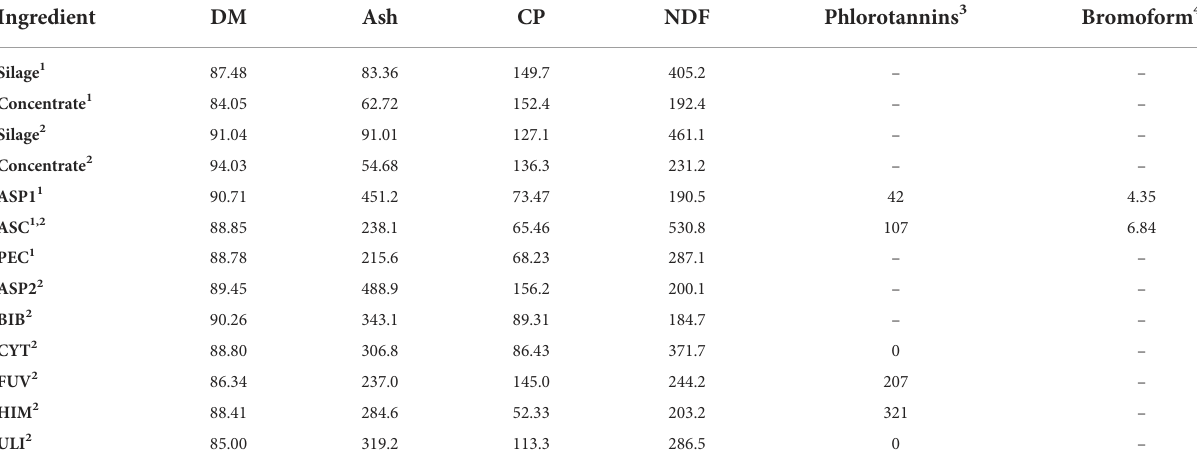
TABLE 2 Chemical composition of seaweed species and basal diet components used in experiment 1 and 2.